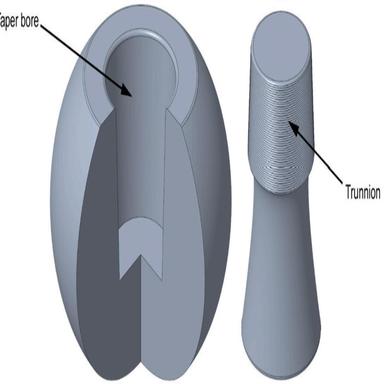
Diagram with cutaway of femoral head and taper piece, illustrating the trunnion and taper bore.